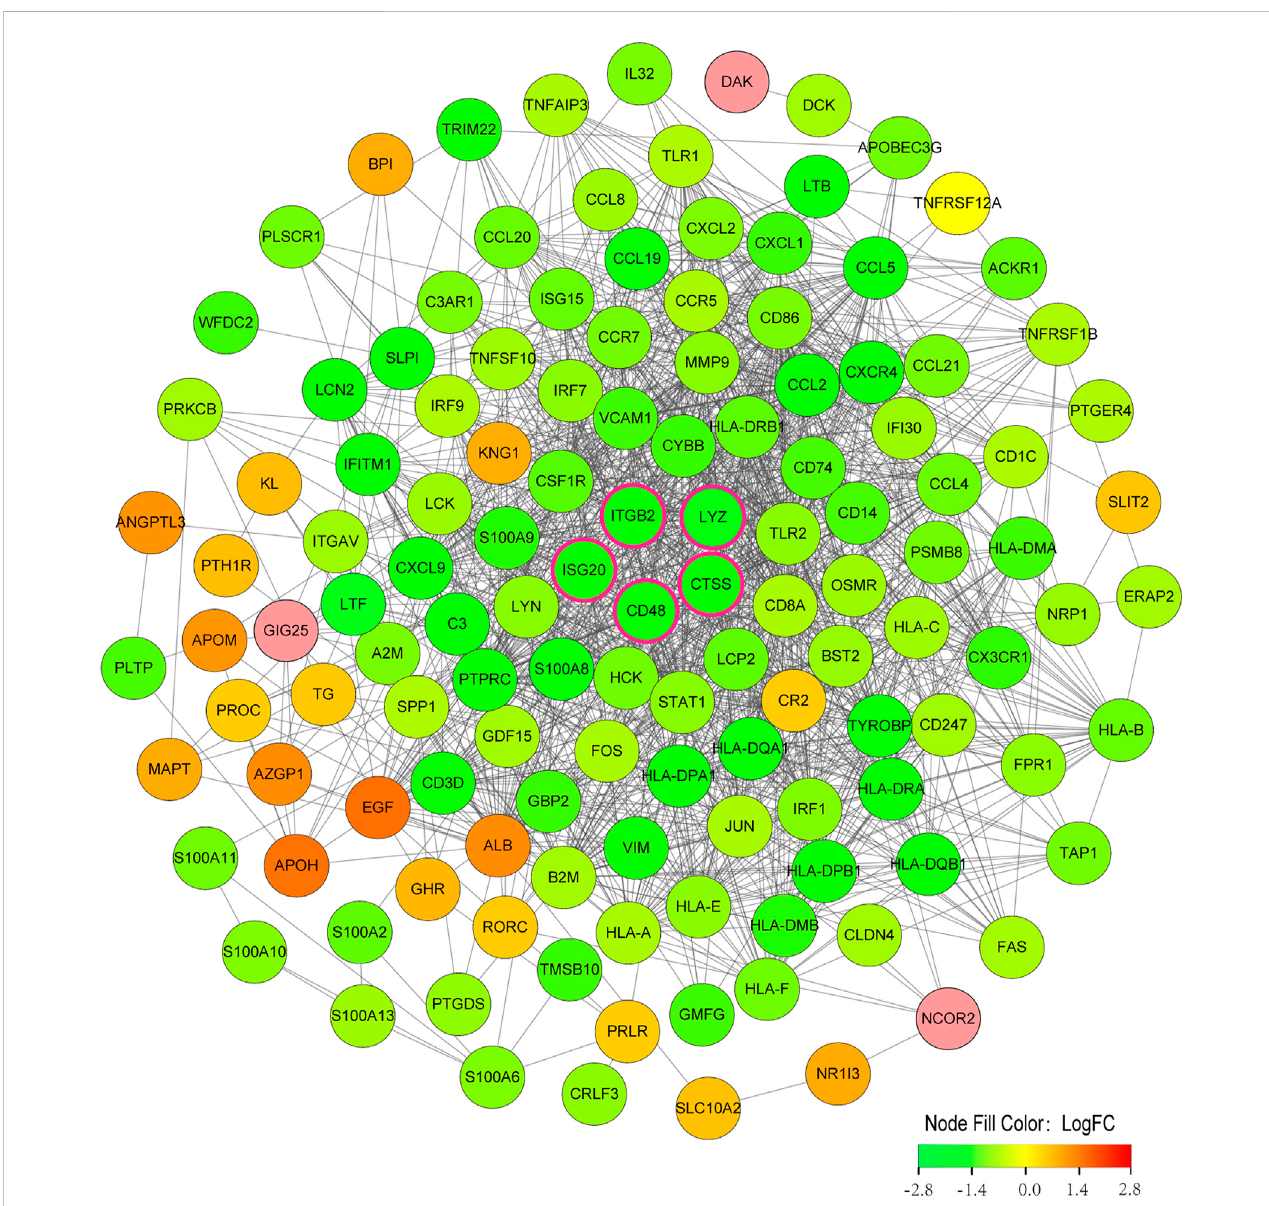
FIGURE 8 PPI network construction of immune-related DEGs among subtypes. Nodes with rose-colored outlines represent key candidate genes, green nodes (negative logFC) represent genes upregulated in Cluster1, and red nodes (positive logFC) represent genes upregulated in Cluster2. FC, fold change.